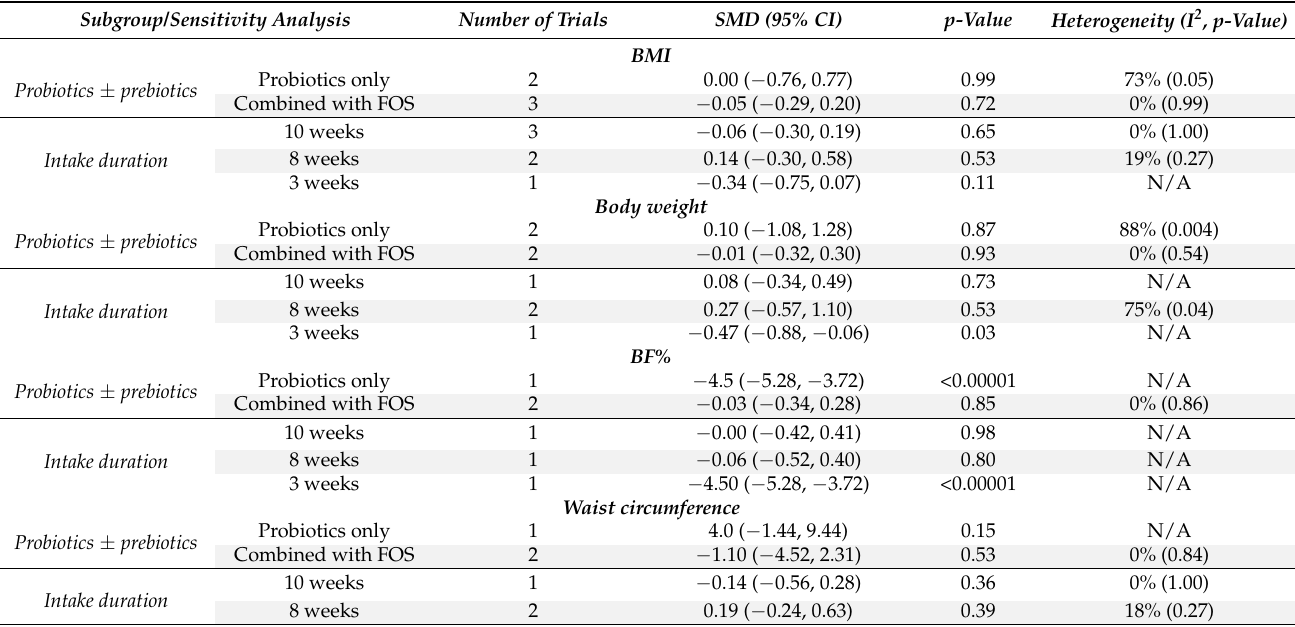
Table 4. Quantitative subgroup analysis for all the included